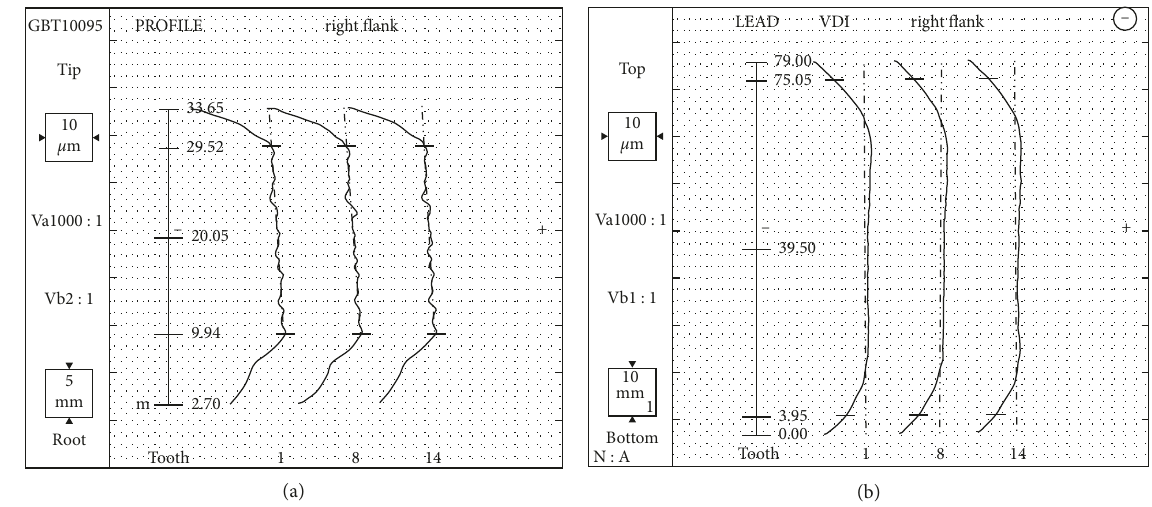
Figure 2: Measured modification curve of pinion: (a) profile modification curve along meshing line direction; (b) lead modification curve. (In actual processing, only one side of the tooth, which is the right flank, is modified, as shown in Figure 2. Three teeth are measured, namely tooth 1, tooth 8, and tooth 14. This paper selects tooth 8 to structure the real tooth surface.)